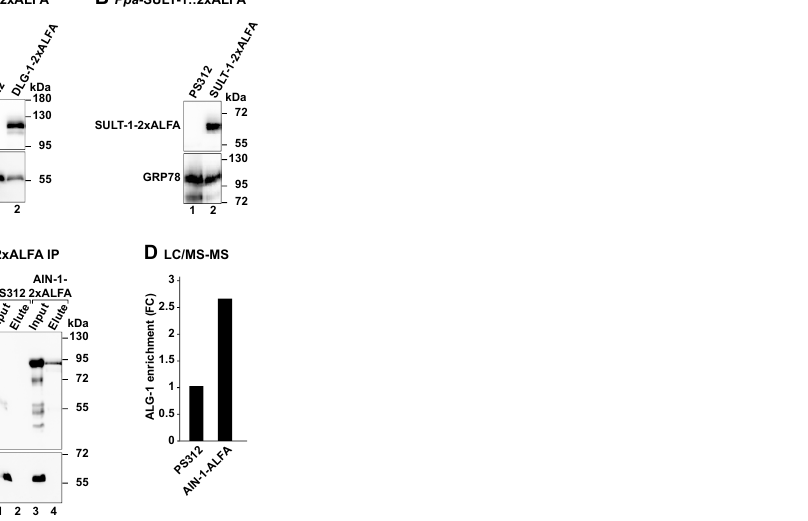
Figure 4. Immunoblotting and pulldown of ALFA-tagged proteins ( A , B ) Western blot showing the expression levels of the ALFA-tagged proteins in the respective worm strains. C. elegans N2 and P. pacificus PS312 worms were used as mock controls for the absence of ALFA-tagged proteins. The blots were developed with anti-ALFA nanobody directly coupled with horse radish peroxidase (HRP) or with a mouse anti-TUBULIN primary antibody followed by anti-mouse IgG-HRP antibody. Molecular weight markers (kDa) are shown next to the blot. ( C ) Affinity purification of Ppa -